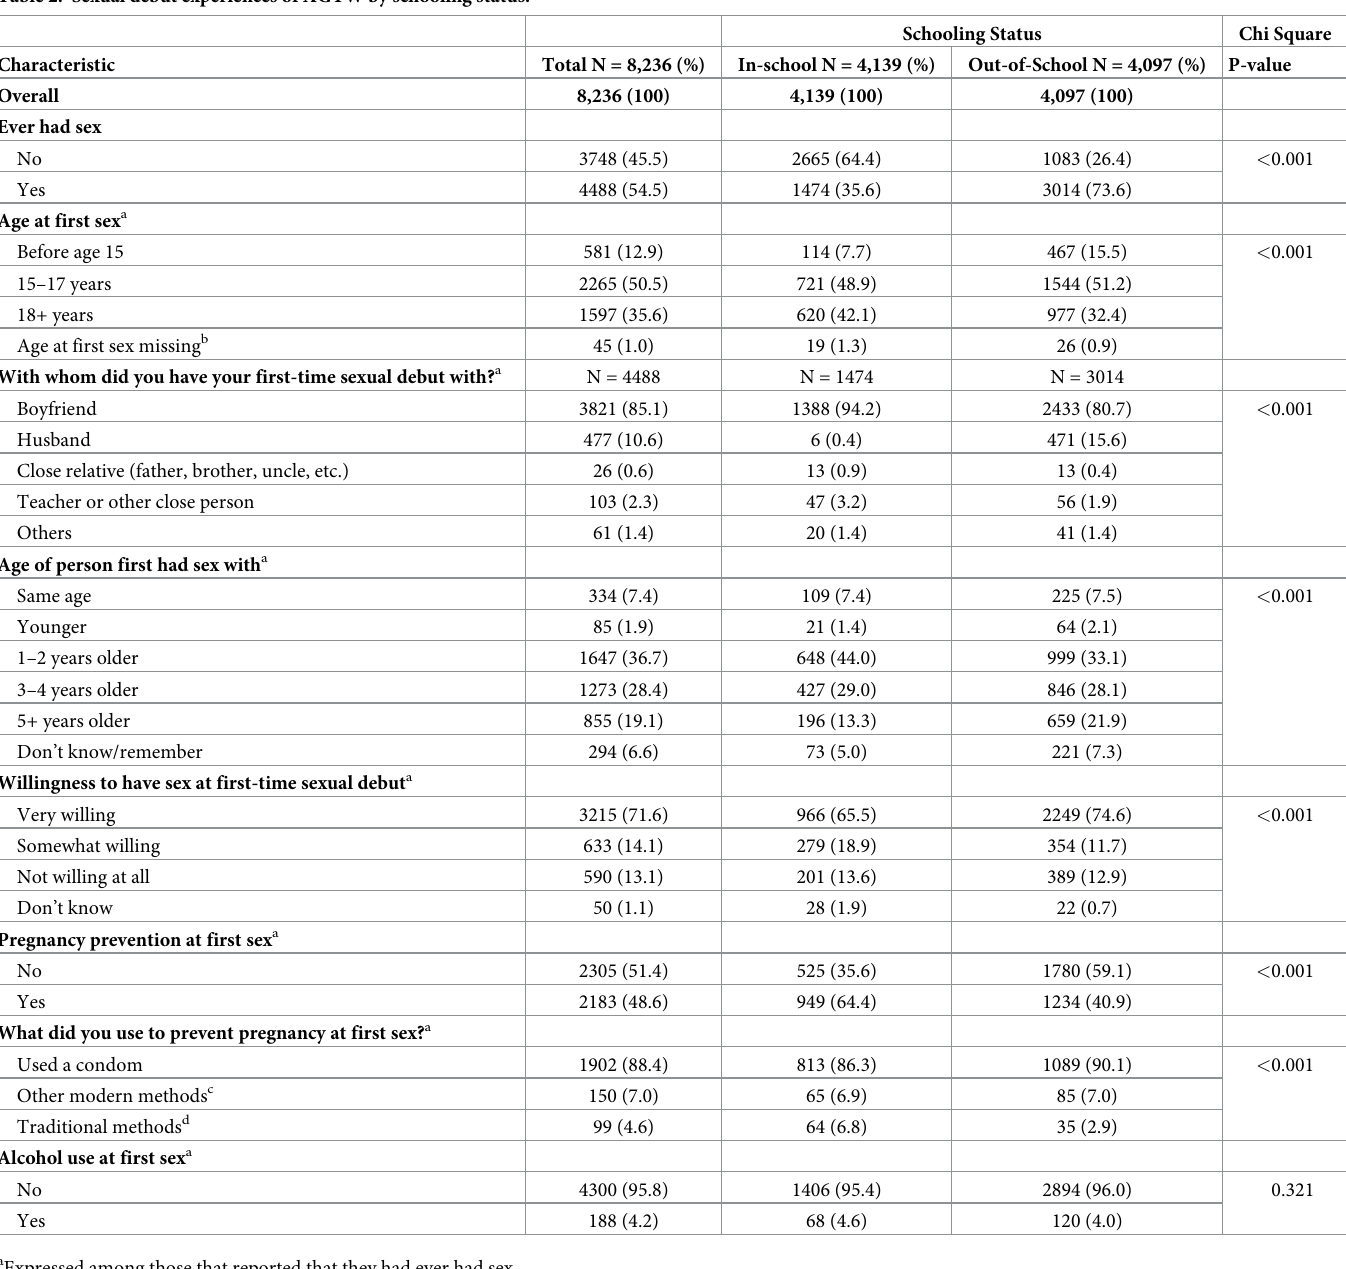
Table 2. Sexual debut experiences of AGYW by schooling status.